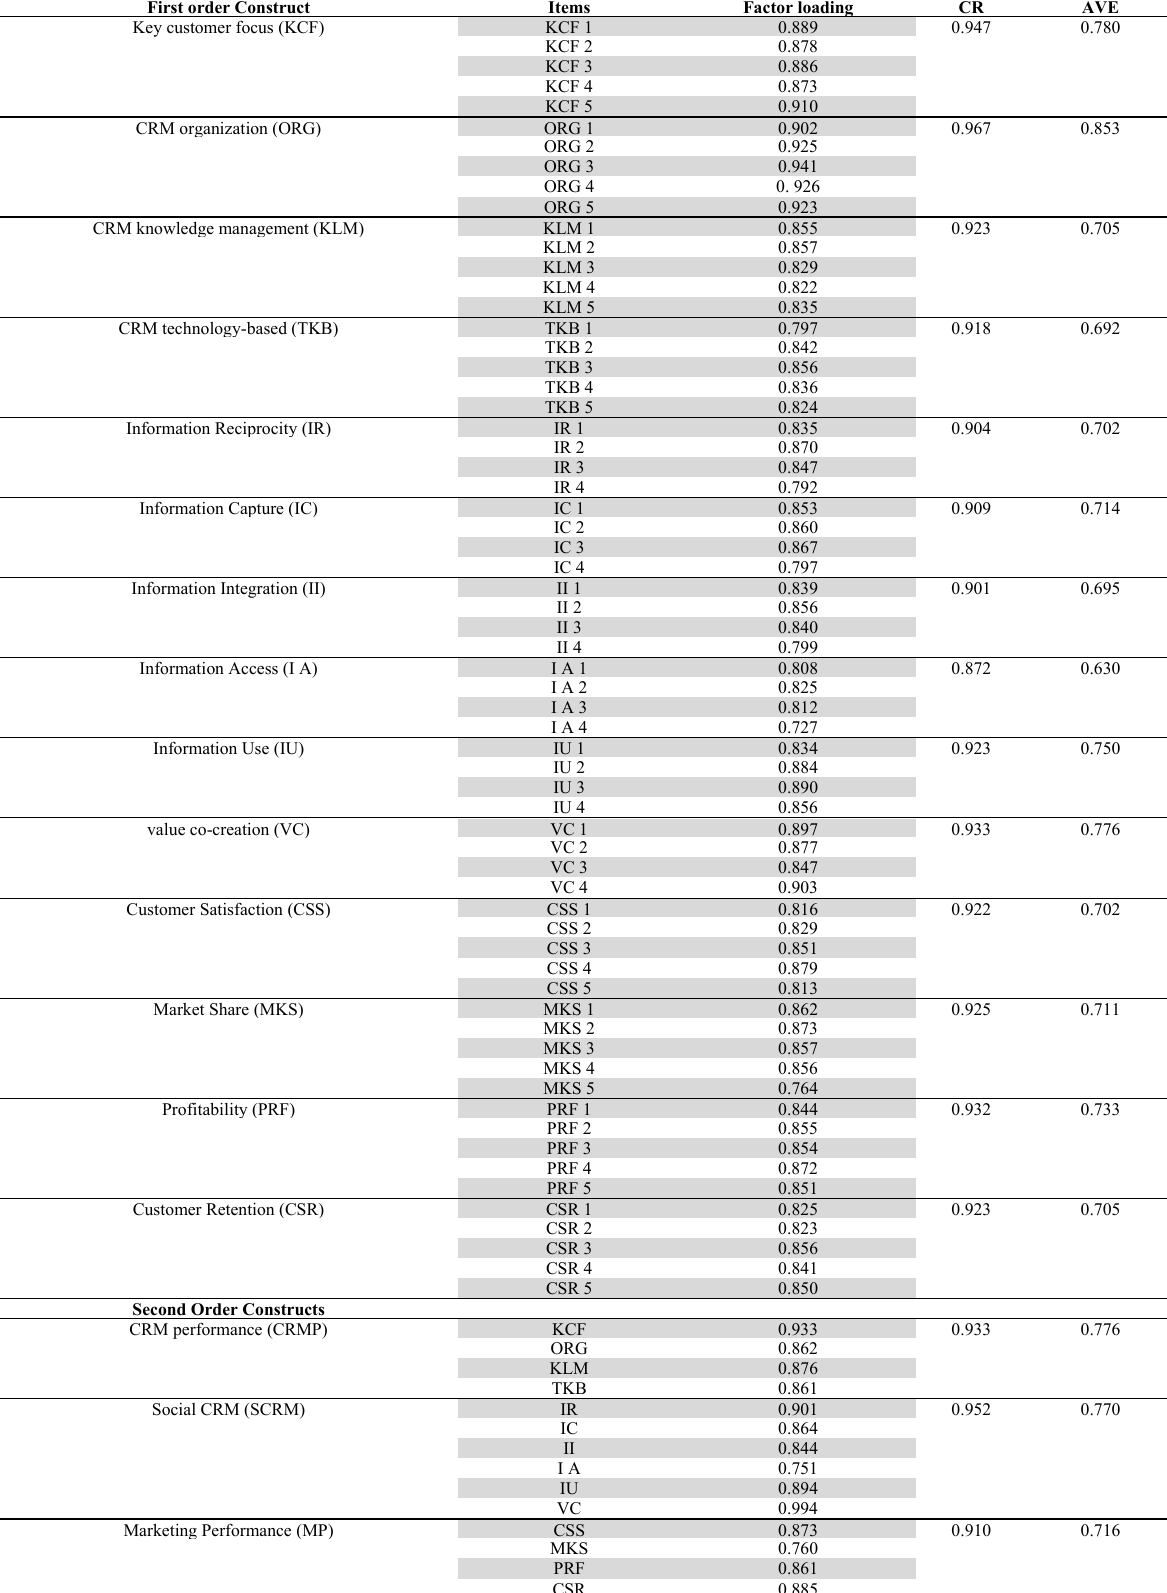
Measurement Model First order Construct Items Factor loading CR AVE Key customer focus